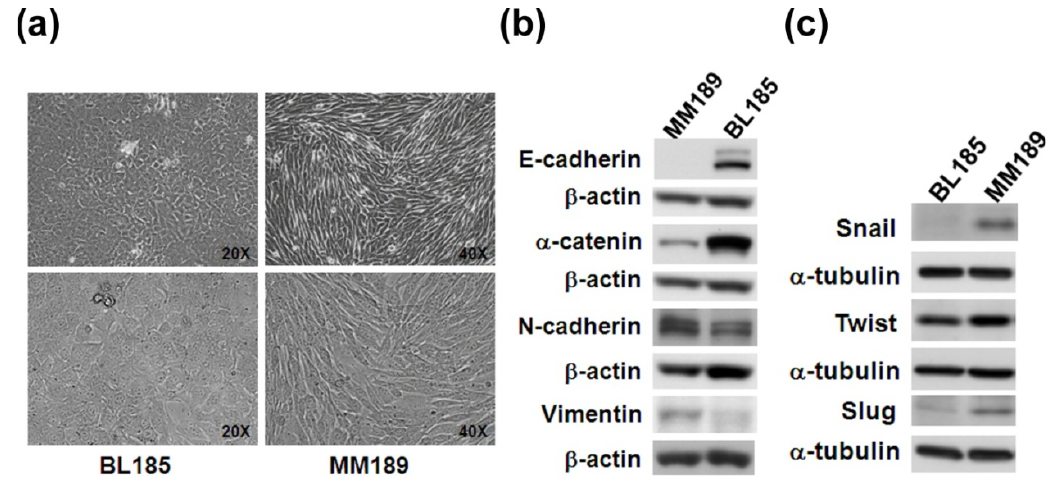
Figure 3. Cell morphology and immunoblot assay for epithelial-mesenchymal transition (EMT) protein markers in BL185 and MM189 cells. ( a ) Phase contrast images of epithelial-like BL185 and mesenchymal-like MM189 grown for 3 days on collagen-coated dishes were taken under a light field microscope at 200× and 400× magnifications; ( b ) Immunoblot analysis of epithelial and mesenchymal proteins including E-cadherin, α -catenin, N -cadherin, and Vimentin in BL185 and MM189 cells. β -actin served as a loading control; and ( c ) Immunoblot analysis of EMT-related transcription factors including Twist, Snail, and Slug in BL185 and MM189 cells. α -tubulin served as a loading